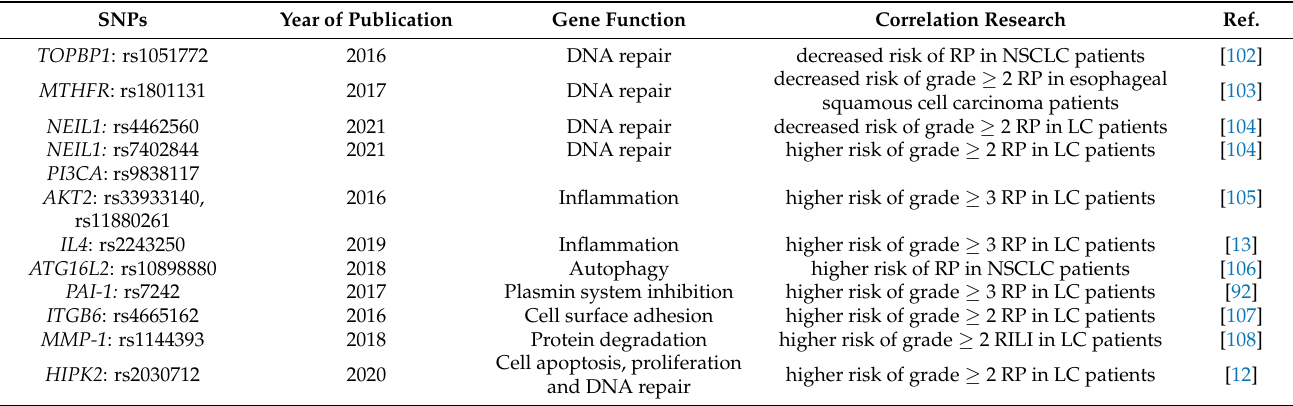
Table 2. SNPs in genes associated with radiation-induced lung